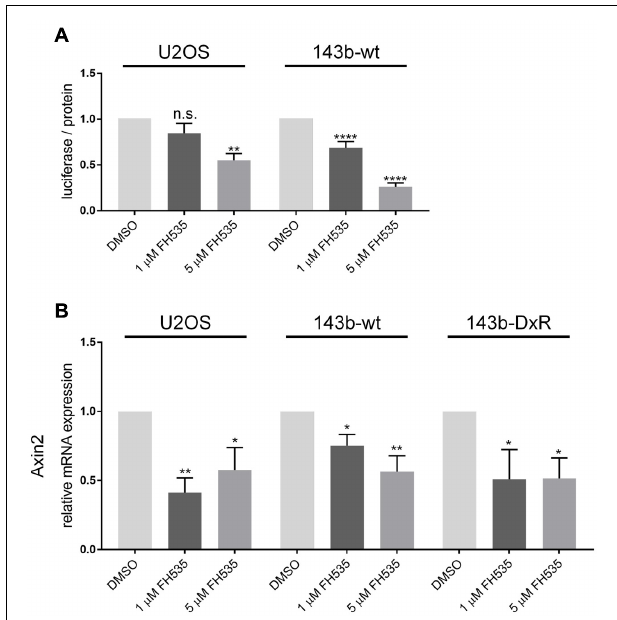
FIGURE 3 | Topflash luciferase activity and Axin2 mRNA indicate inhibition of Wnt signaling (A) . Luciferase activity of Topflash reporter-transfected 143b-wt (left) and U2OS (right) cell line following 24 h treatment with FH535. ( n = 6). (B) Expression of Axin2 mRNA after 24 h treatment with FH535 in 143b-wt, U2OS, and 143b-DxR cell lines. ( n = 3). Data information: Data are presented as mean, ± SD. Statistical significance determined by one-way ANOVA with Tukey’s multiple comparison test, ∗∗ indicates p < 0.01, ∗∗∗∗ indicates p < 0.0001, “n.s.” indicates no statistically significant